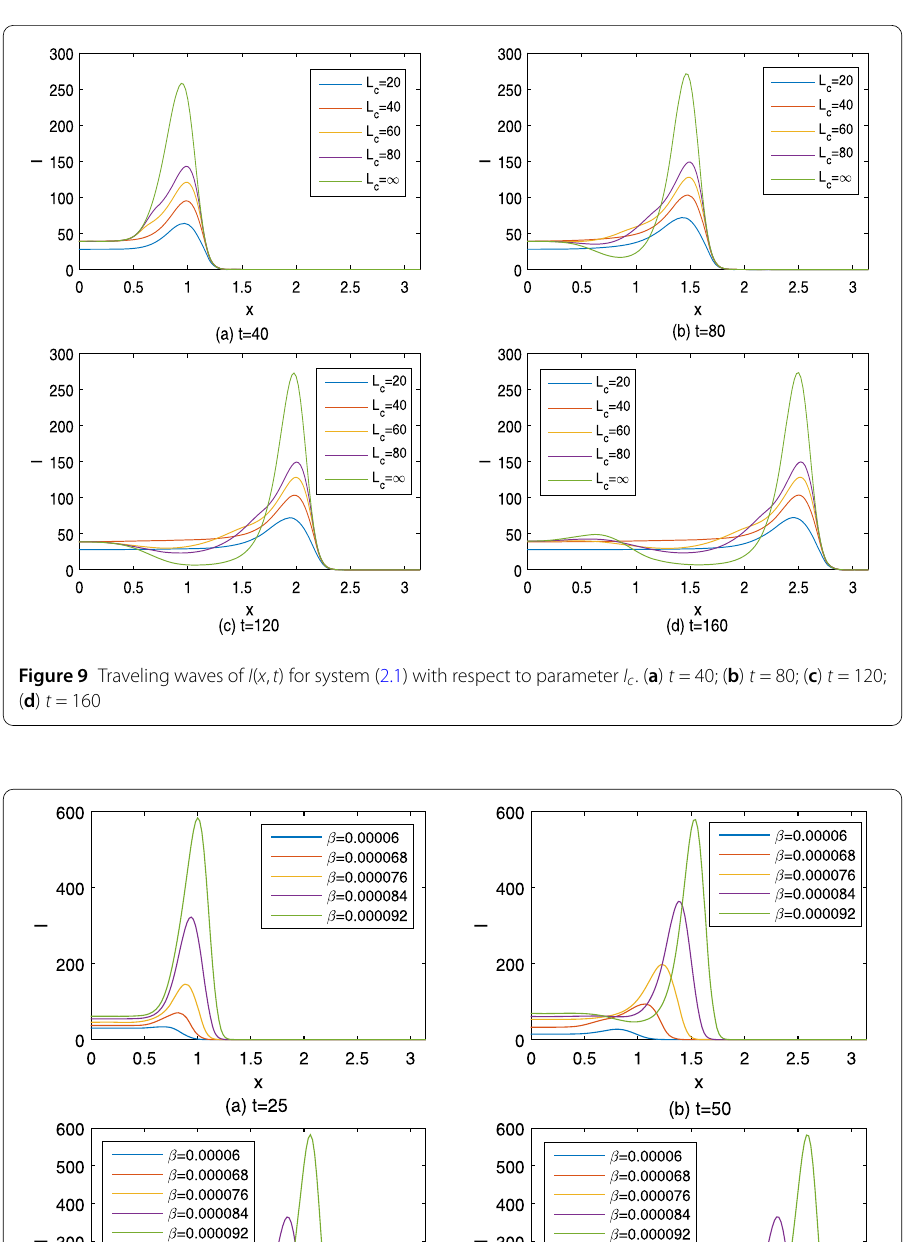
the severity of the spread of disease in space, we should reduce the value of the contact transmission rate β